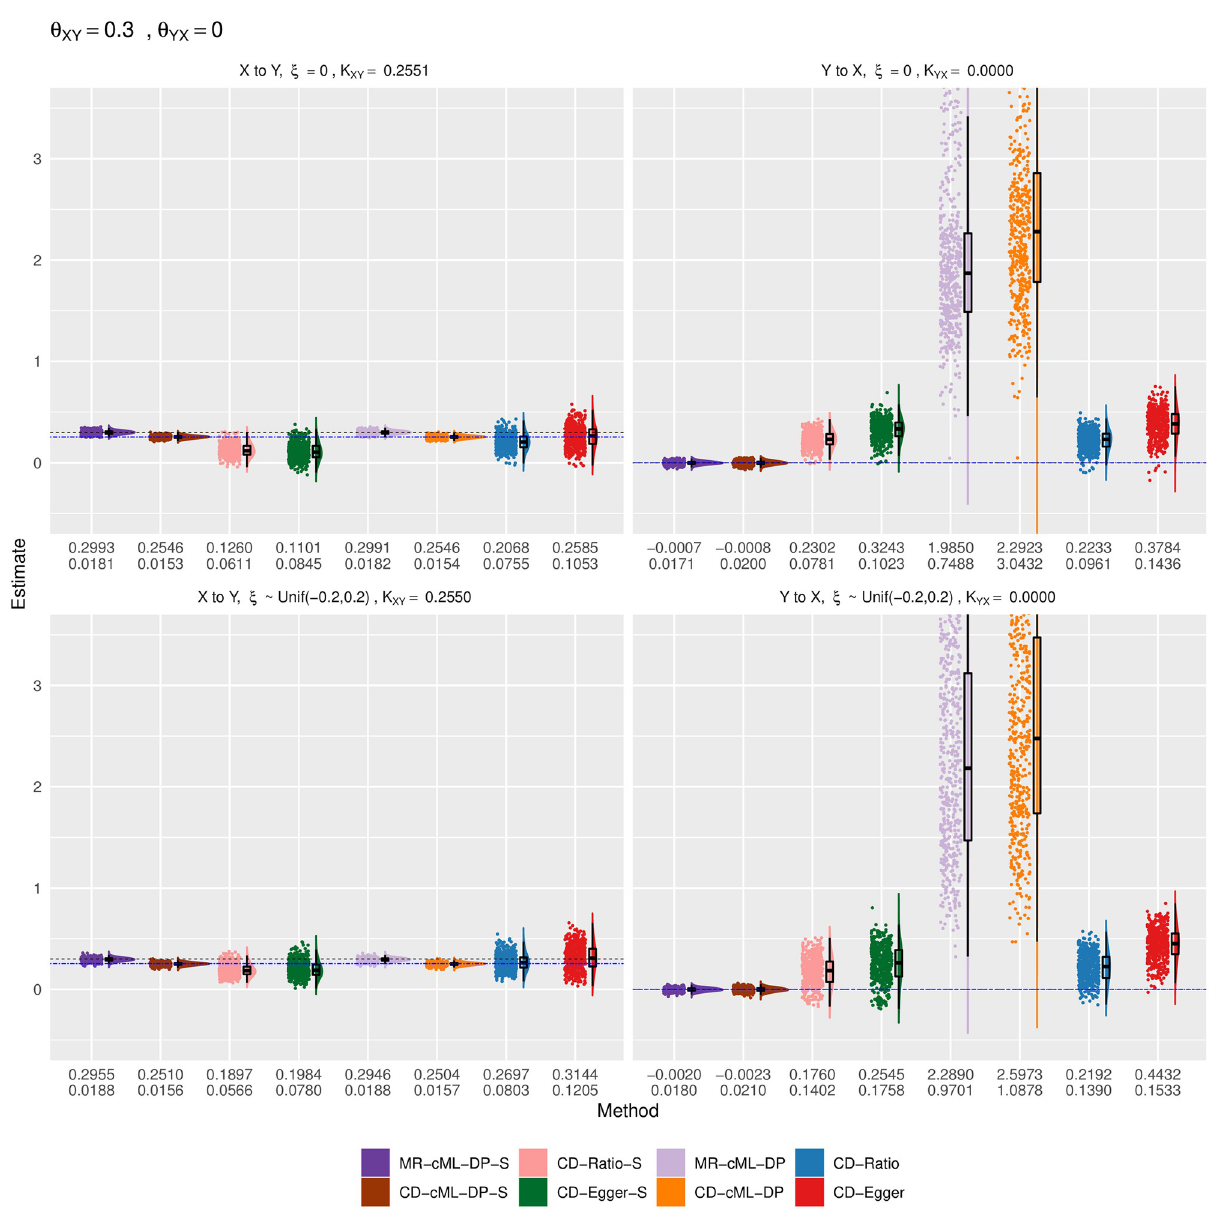
Fig 8. Empirical distributions of the estimates of the correlation ratio K for CD methods and the causal effect θ for MR method with both X and Y continuous, true θ XY = 0.3 and θ YX = 0. The top and bottom panels show the results for ξ = 0 (i.e. no correlated pleiotropy) and ξ from a uniform distribution (i.e. with correlated pleiotropy, implying InSIDE violated), respectively. The left panels show the estimates for the causal direction of X ! Y , while the right ones show that for Y ! X . The horizontal dashed lines are for the true values of K (in blue) and θ (in black). The two rows of the numbers under each panel give the sample mean and standard deviation of the estimates from each